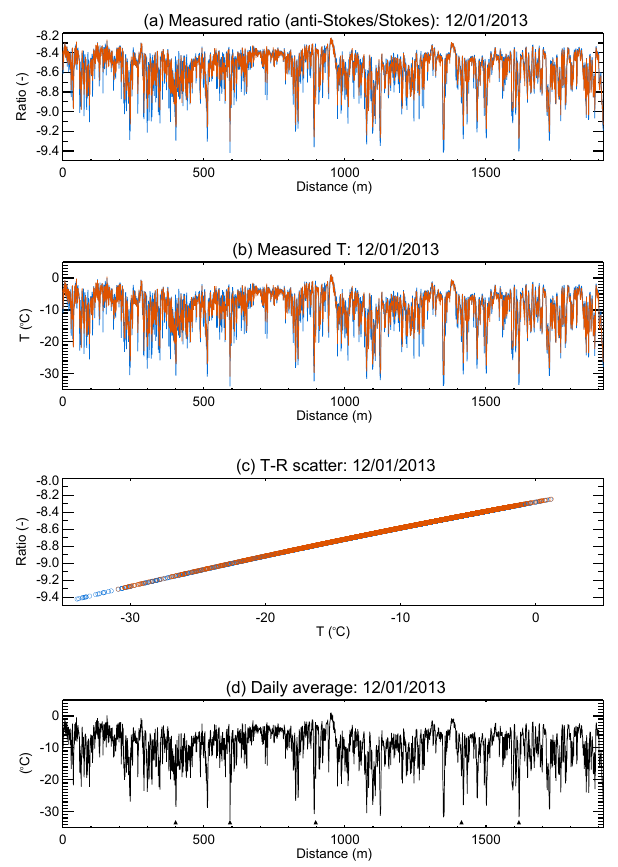
Figure 4. Examples of outputs from the DTS equipment. (a) The logarithmic ratio between the Stokes and anti-Stokes components and (b) temperature of an instantaneous measurement, made at 02:32 (blue) and 13:39 (orange) on 1 December 2013, for a hori- zontal section of the DTS system. (c) Scatter plot between (a) and (b) for the respective time. (d) Average of the temperature measure- ments for the